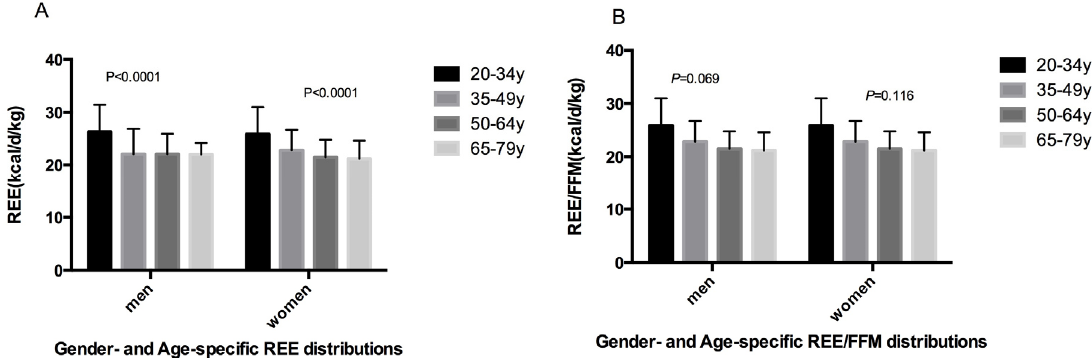
Figure 1. Gender ‐ and age ‐ specific resting energy expenditure ( REE) ( A ) and REE/FFM ( B ) Figure 1. Gender- and age-specific resting energy expenditure (REE) ( A ) and REE/FFM ( B ) distributions. distributions. p ‐ Value, statistically significant difference of mean values across age groups. p -Value, statistically significant difference of mean values across age